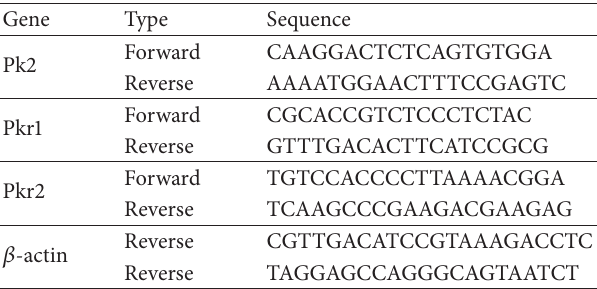
Table 1: Real time qPCR primer